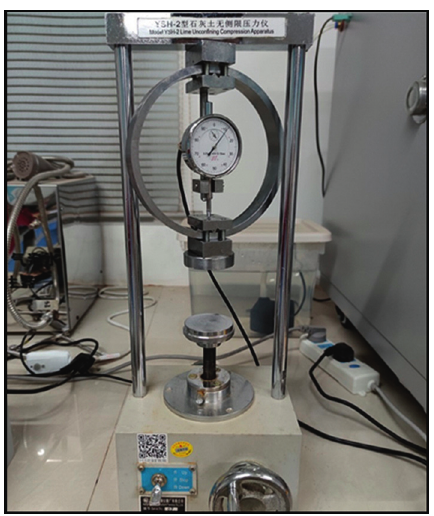
Figure 8: Device for unconfined